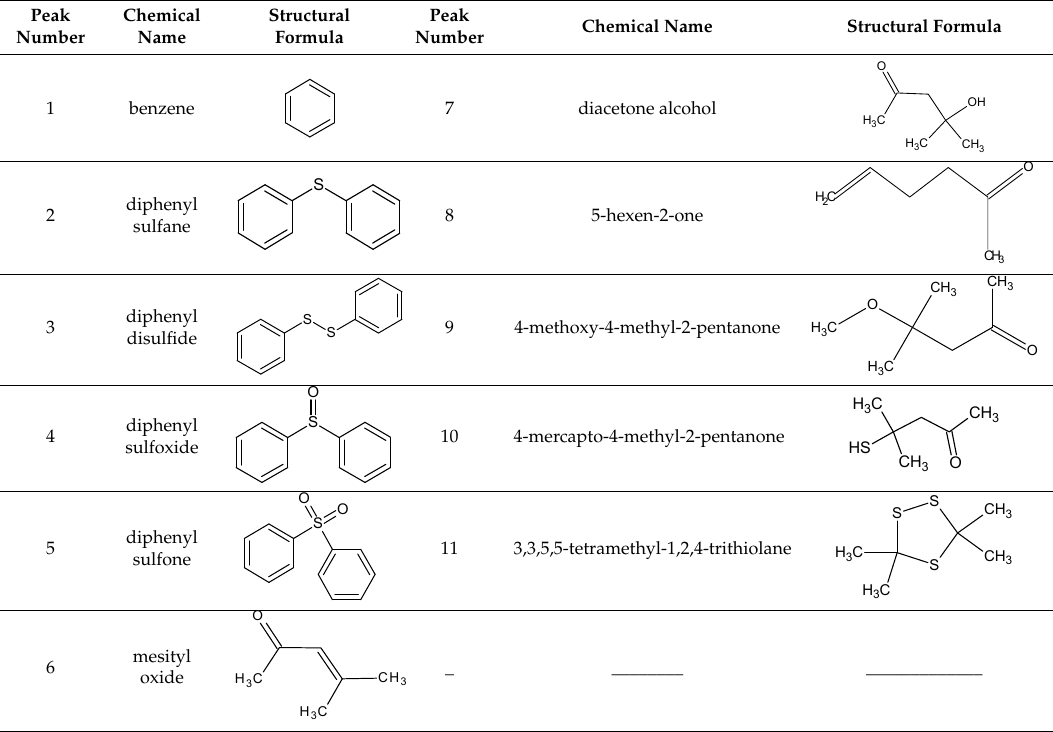
Figure 4. GC-MS of the oxidation products of cysteine. Table 1. GC/MS-detectable compounds in organic sulfur compound extracts.